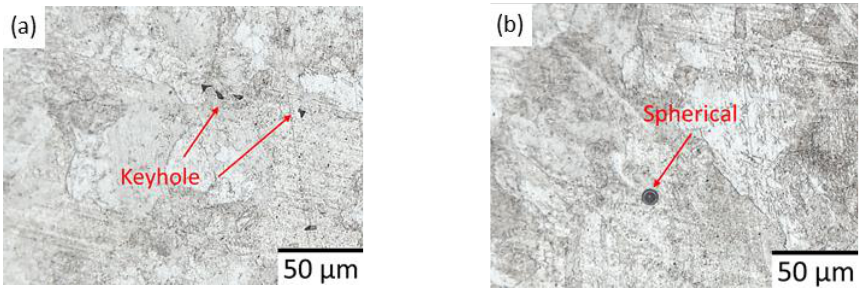
Figure 15. The type of porosity observed from three different areas of 0° build direction; ( a ) keyhole and ( b ) spherical porosity.